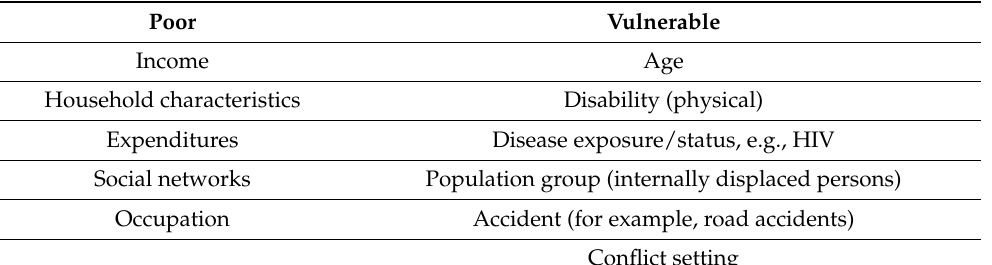
Table 5. Responses from participants in defining and categorising poor and